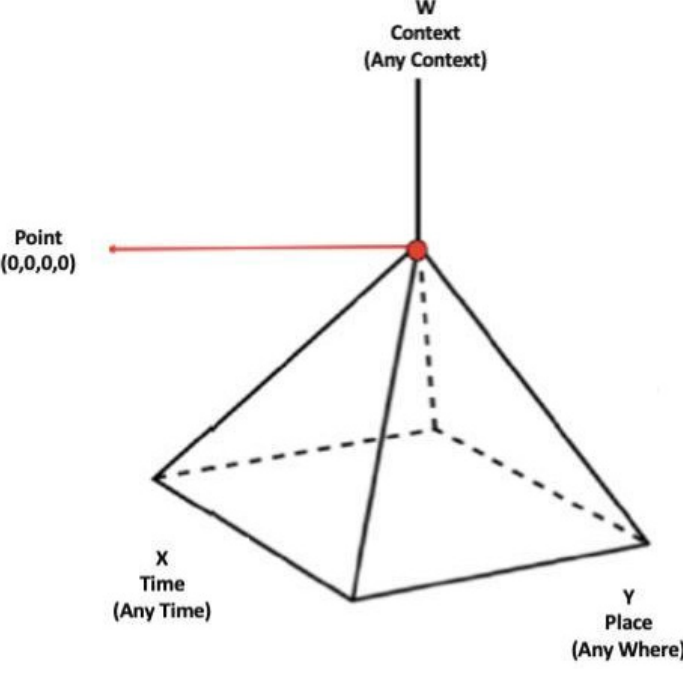
Figure 6. U-CLX Model Pyramid